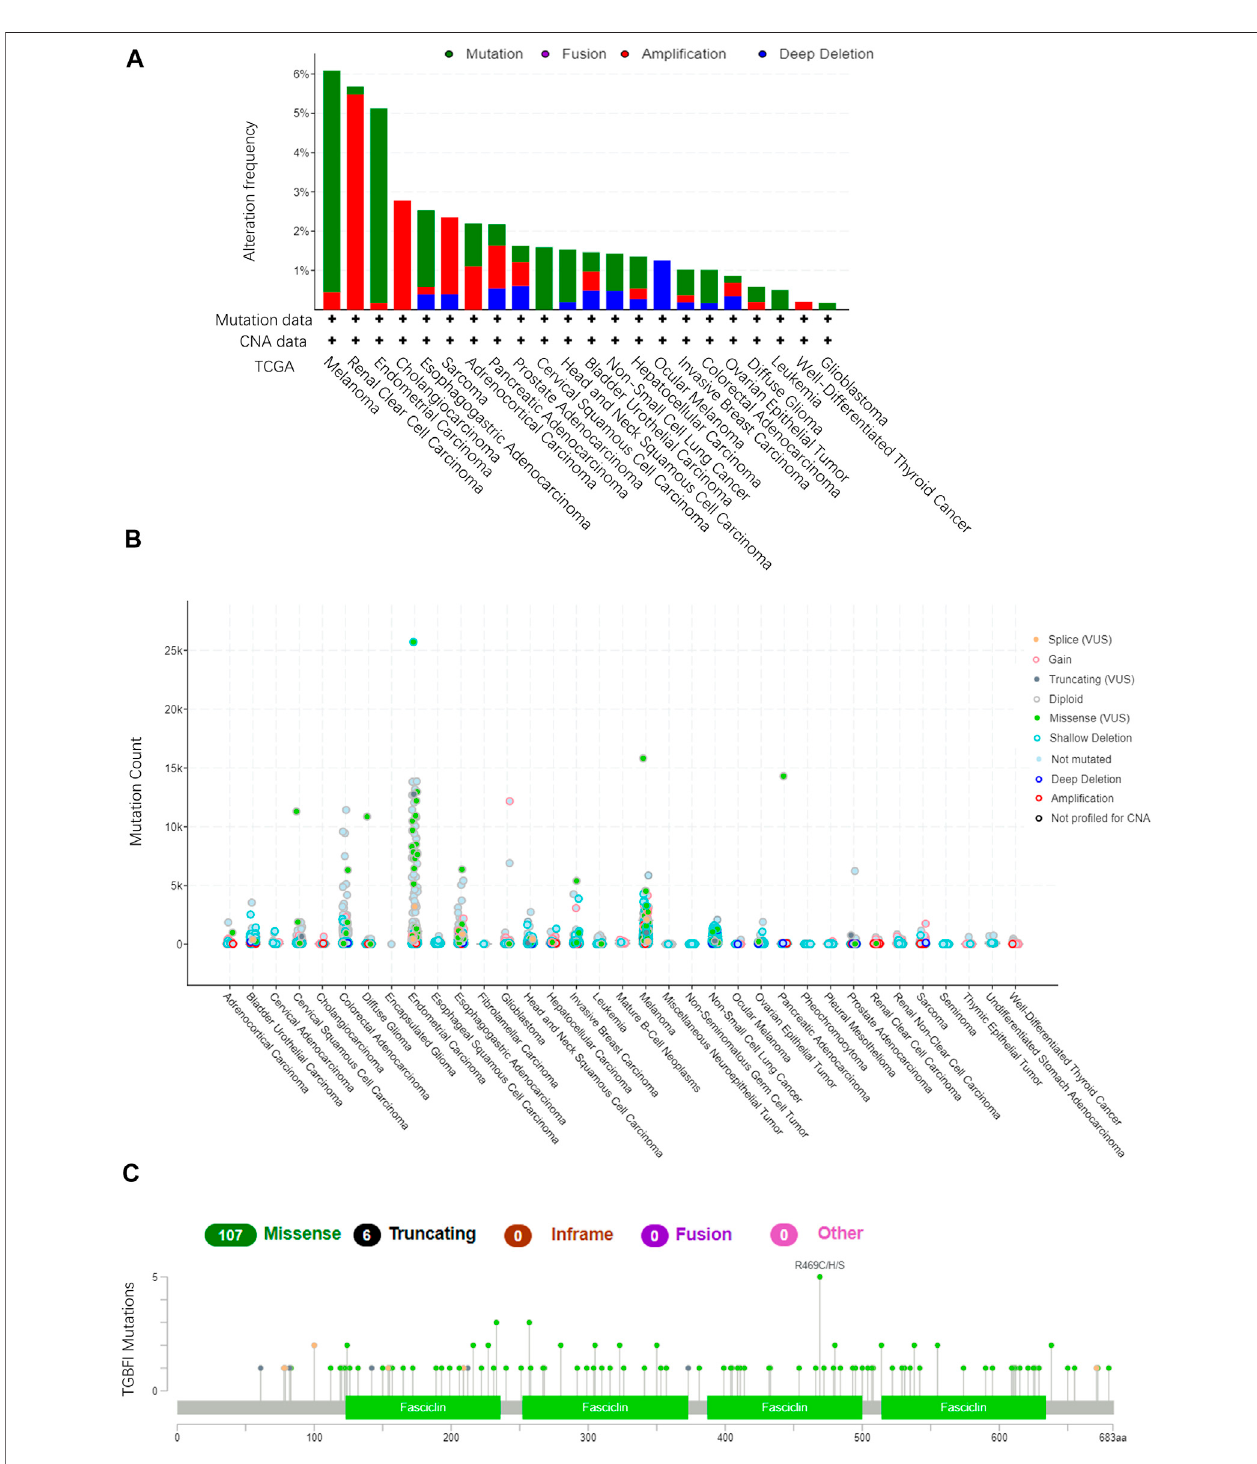
FIGURE 6 | TGFBI mutation landscape in various cancer types. (A) TGFBI mutation frequency in various TCGA pan-cancer studies according to cBioPortal. (B) TGFBI mutation count in various TCGA cancer types according to cBioPortal. (C) TGFBI mutations across protein domains in various cancer